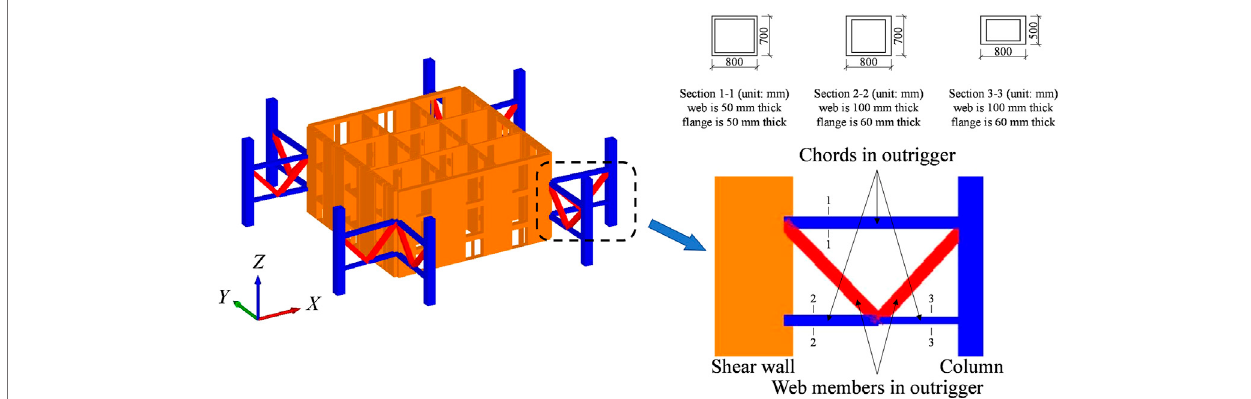
FIGURE 3 | Arrangement of outrigger.